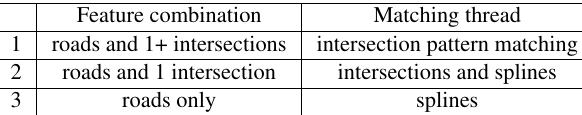
Table 1: Correspondence between features present in the frame and initiated association